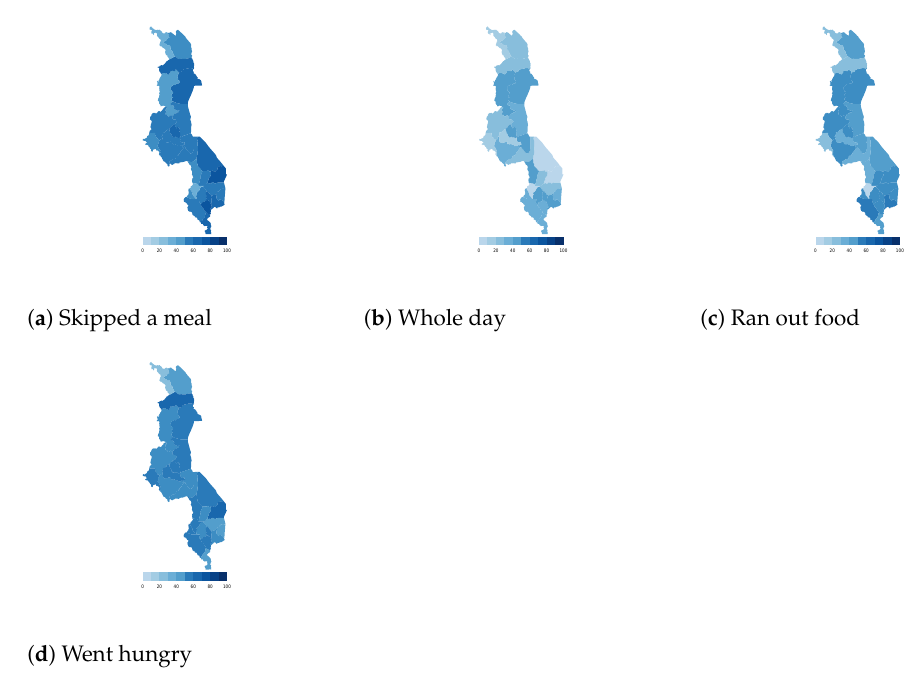
Figure 7. Malawi—share of households.